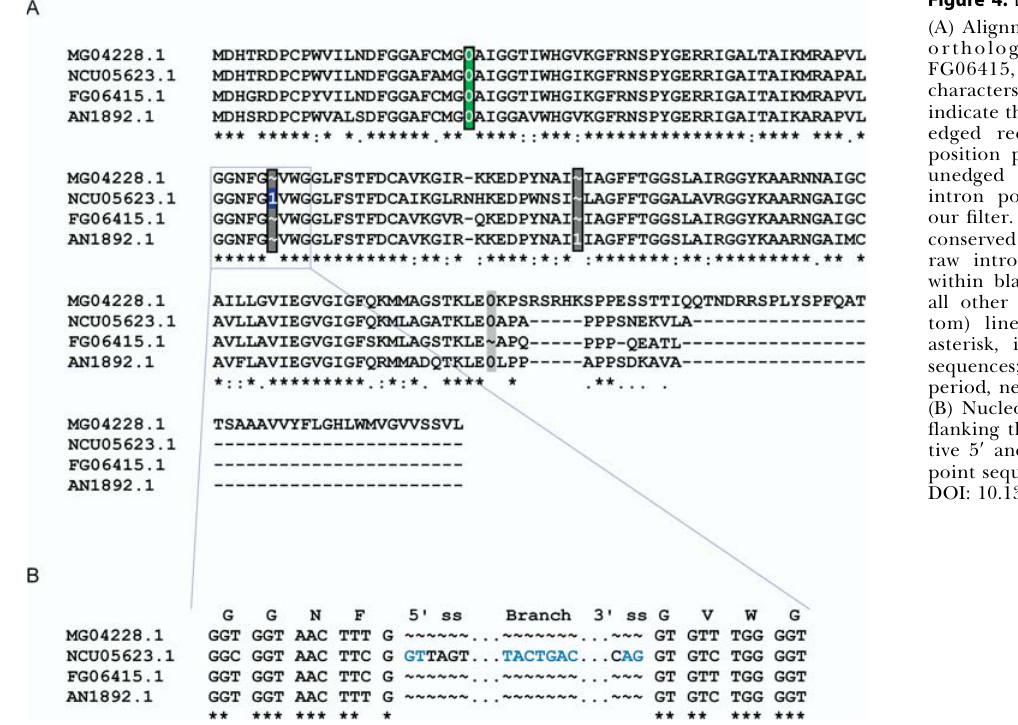
Figure 4. Example Ortholog Alignment (A) Alignment of protein sequences for orthologs MG04228, NCU05623, FG06415, and AN1892 with intron characters inserted. ‘‘ 0, ’’ ‘‘ 1, ’’ and ‘‘ 2 ’’ indicate the phase of an intron. A black- edged rectangle indicates an intron position passing our quality filters; an unedged gray rectangle indicates an intron position that was removed by our filter. The green rectangle indicates conserved introns, the blue box marks a raw intron gain, and the gray boxes within black-edged rectangles highlight all other introns. The consensus (bot- tom) line characters are as follows: asterisk, identical residue in all four sequences; colon, similar residue; and period, neutral residue. (B) Nucleotide alignment of the region flanking the gained intron in (A). Puta- tive 5 9 and 3 9 splice sites and a branch point sequence are highlighted in